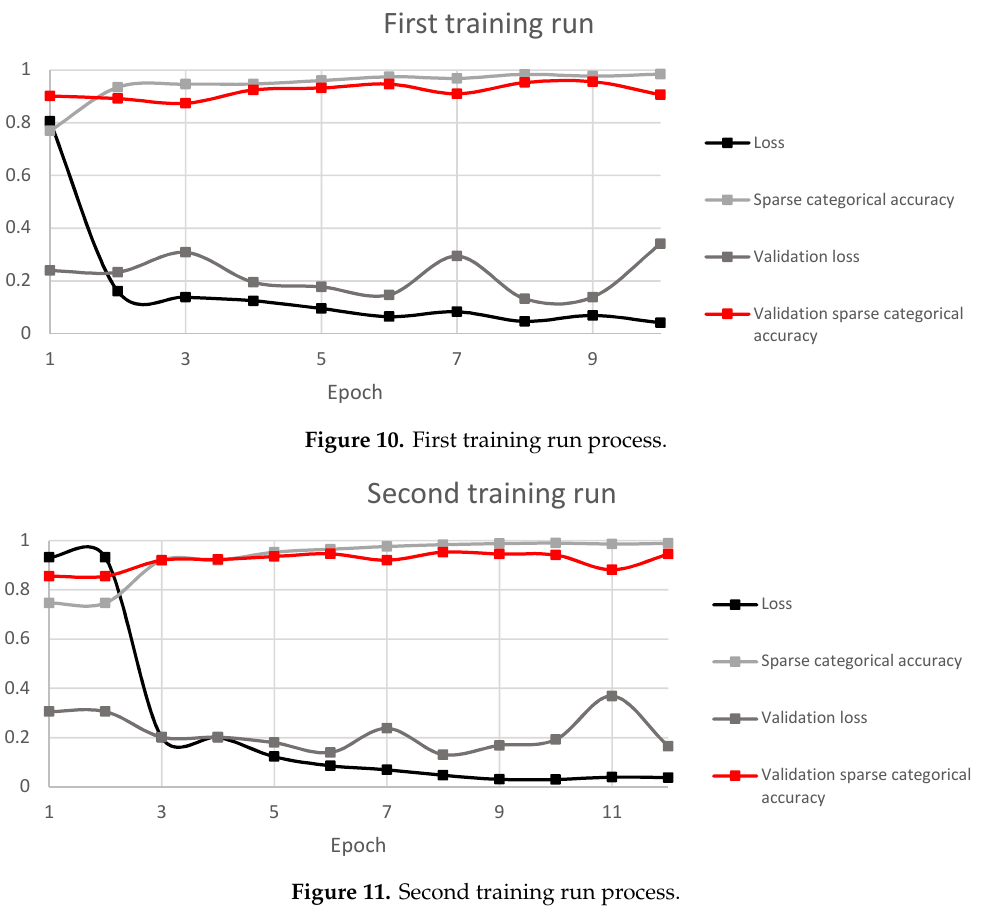
Figure 12. Third training run process.